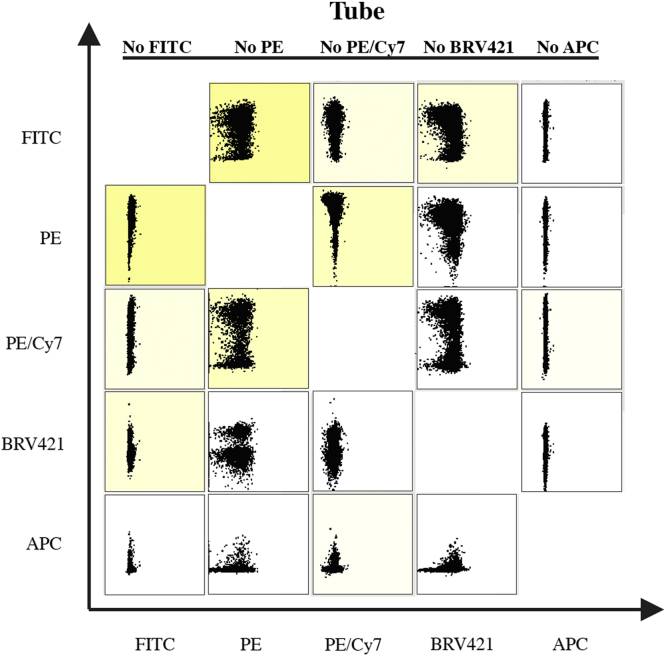
Fluorescence minus one (FMO) assay ensures that no false positive signaling are present. Summarizing chart of multiple flow cytometry dot plot-profiles. Each dot represents one cell that are plotted on its staining intensity of the X- and Y-axis fluorochromes. In five tubes, freshly isolated murine keratinocytes were stained with the antibodies Plet-1-APC, Sca-1-PE/Cy7, Itgα6-PE, CD34-BRV421 and Krt14-FITC. However, each tube only contained four of the five antibodies, excluding one (No FITCH, No PE, No PE/Cy7, No BRV421 and No APC). For each of the excluded antibodies, the flow cytometer will detect any false positive signal that are caused by spectral overlaps from the other fluorochrome emission signals.